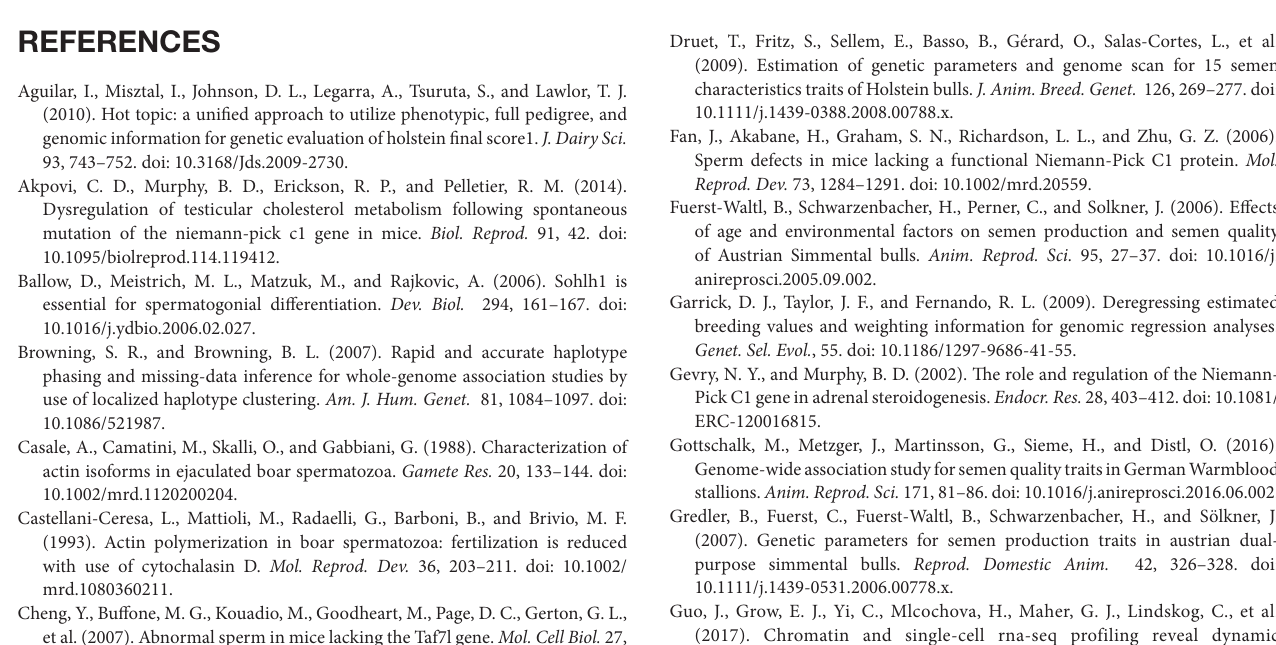
FIGURe S1 | GWAS results of ejaculate volume (VE) in Holstein bulls of China. Each dot represents one SNP. The X-axis represents 29 autosomes, respectively. The Y-axis represents the log10 of the P-Value by SNP. FIGURe S2 | GWAS results of sperm concentration (SC) in Holstein bulls of China. Each dot represents one SNP. The X-axis represents 29 autosomes, respectively. The Y-axis represents the log 10 of the P-Value by SNP. FIGURe S3 | GWAS results of progressive sperm motility (MS) in Holstein bulls of China. Each dot represents one SNP. The X-axis represents 29 autosomes, respectively. The Y-axis represents the log10 of the P-Value by SNP. FIGURe S4 | GWAS results of number of motile sperm (NMSP) in Holstein bulls of China. Each dot represents one SNP. The X-axis represents 29 autosomes, respectively. The Y-axis represents the log10 of the P-Value by SNP. FIGURe S5 | GWAS results of number of sperms per ejaculate (NSP) in Holstein bulls of China. Each dot represents one SNP. The X-axis represents 29 autosomes, respectively. The Y-axis represents the log10 of the P-Value by